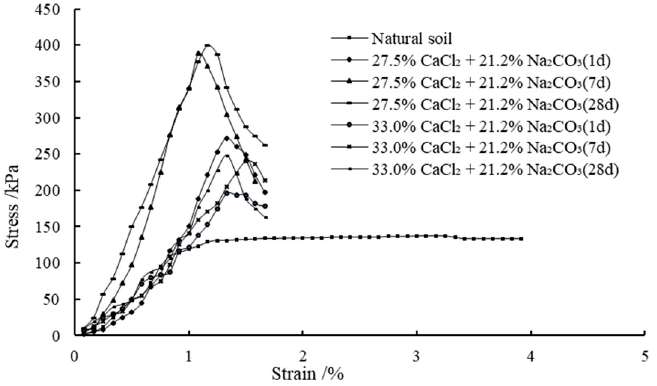
Figure 7. The stress–strain behavior of Series 2 samples with different curing periods.